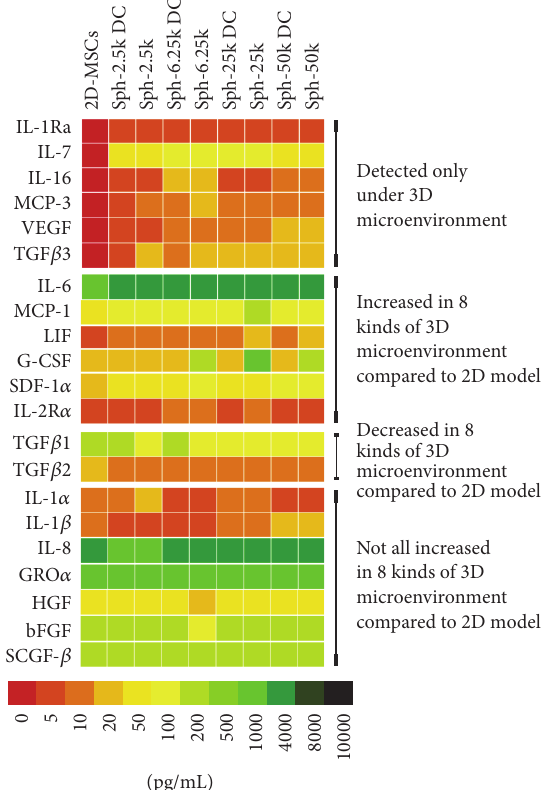
Figure 3: Heatmap of signal factor secretion by 2D-MSCs and 3D-MSCs cultured at different conditions. Six signal factors, IL- 1Ra, IL-7, IL-16, MCP-3, TGF 𝛽 3, and VEGF, were detected only under 3D culture conditions. 5 signal factors, IL-6, MCP-1, LIF, G- CSF, and SDF-1 𝛼 , were higher in conditioned medium from all 3D cultureconditionscomparedtothe2Dculturecondition.Twosignal factors, TGF 𝛽 1 and TGF 𝛽 2 had decreased levels in conditioned media from 3D culture conditions compared to the 2D culture